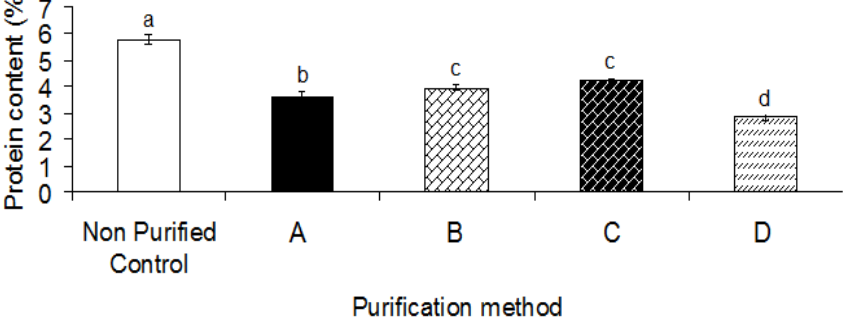
Figure 2. Effect of different purification methods on the protein content of heteropolysaccharide-protein biopolymer from durian seed. A, isopropanol and ethanol; B, isopropanol and acetone; C, saturated barium hydroxide; D, Fehling